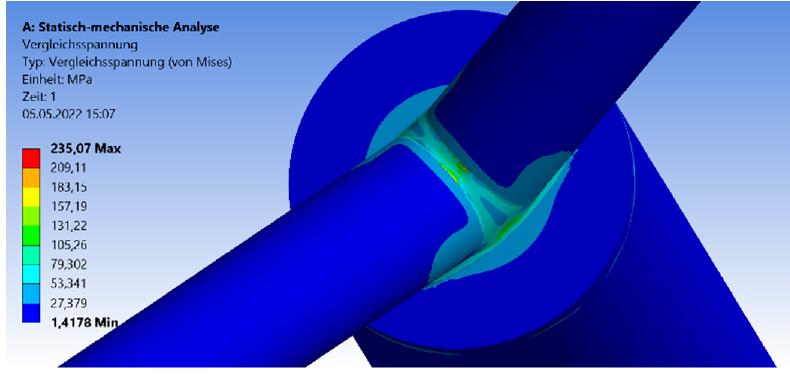
Figure 17. Von ‐ Mises Stress Distribution—1.5 ‐ m chord length. Figure 17. Von-Mises Stress Distribution—1.5-m chord length.